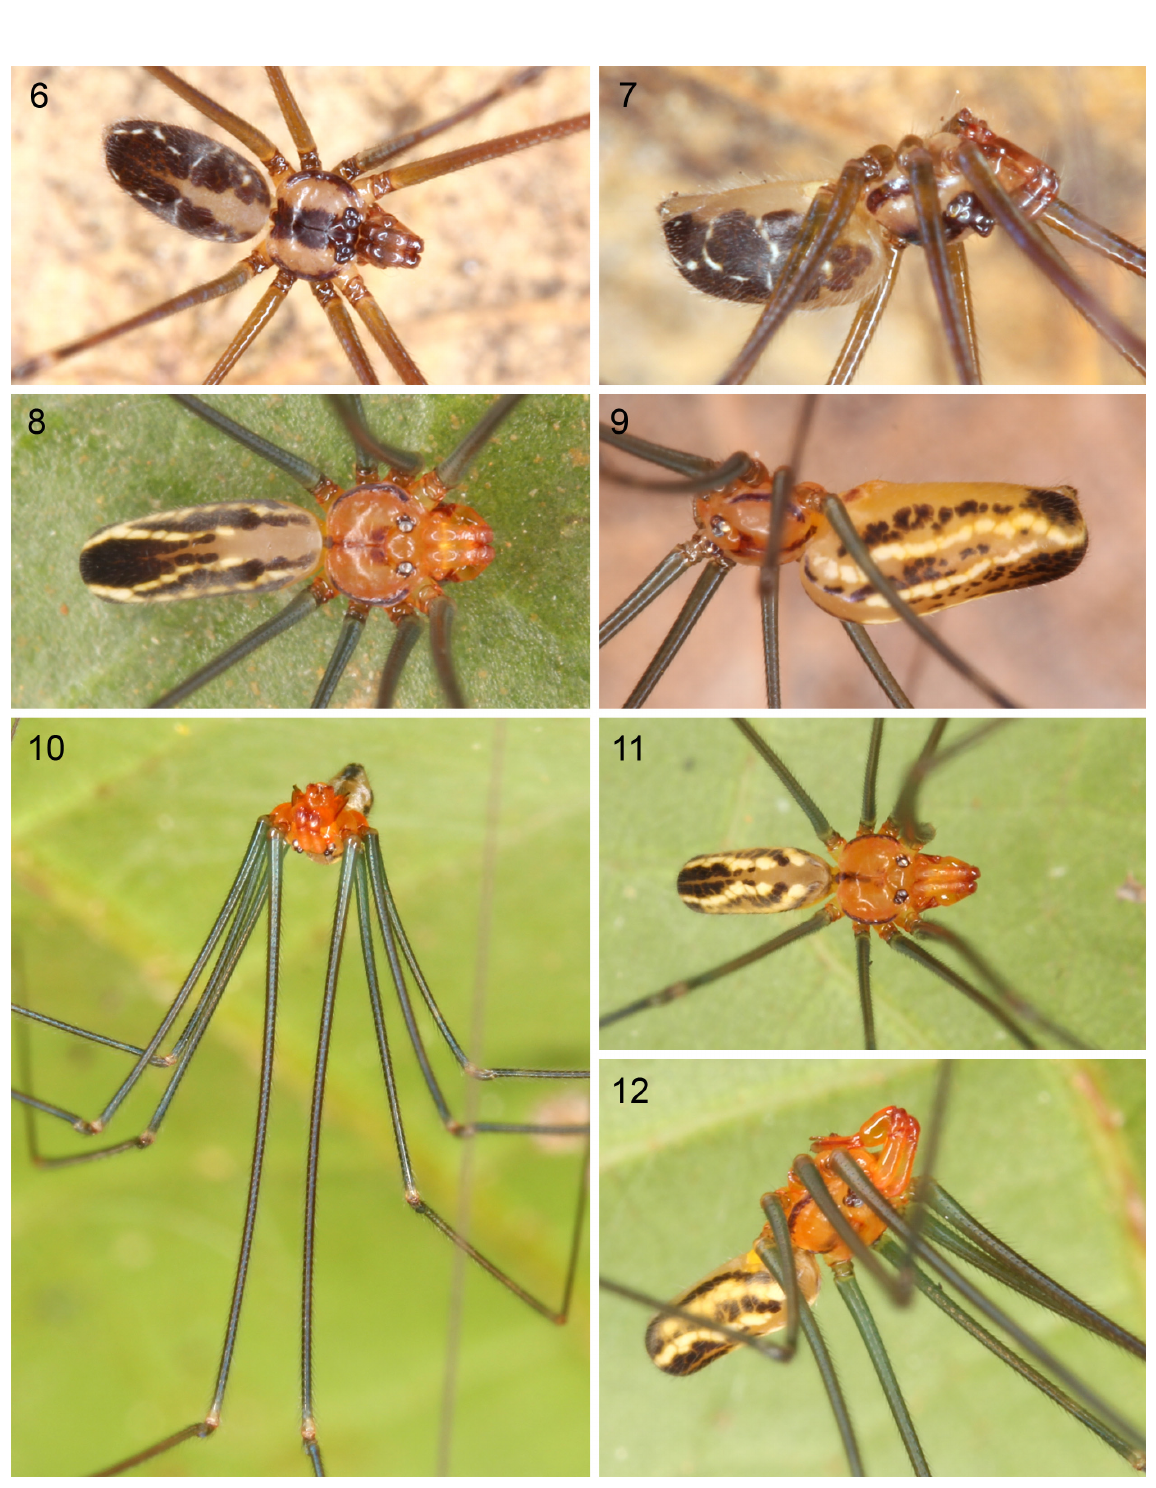
Figs 6–12. Live specimens. Aetana ocampoi group. 6–7 . A. ocampoi Huber, sp. nov., ♂ from Mt. Isarog, Luzon. 8–9 . A. libjo Huber, sp. nov., ♂ and ♀ from Dinagat Island, Mindanao. 10–12 . A.